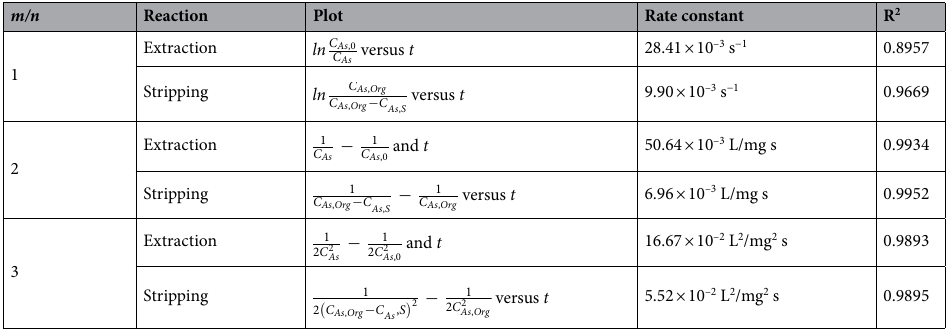
Table 6. Reaction order ( m / n ) and reaction rate constants of extraction and stripping of arsenic ions ( k As,Ex and k As,S ). C As , concentration of arsenic ions in the feed solution at time t ; C As,0 , concentration of arsenic ions in the inlet feed solution; C As,Org , initial concentration of arsenic ions in the organic extractant; C As,S , concentration of arsenic ions in the stripping solution at time t.